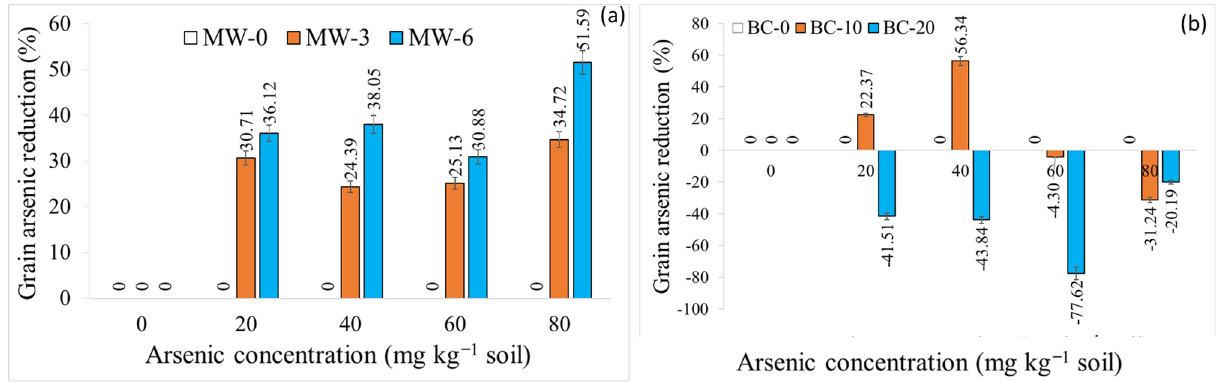
Figure 8. Grain arsenic (As) concentration reduction in response to ( a ) microwave (MW) and ( b ) biochar (BC) treatments at different soil As concentrations. The mean values are shown in the bar along with standard error and value of difference. A positive value indicates the reduction of grain As accumulation while, zero and negative values show no reduction and increase in concentration, respectively.